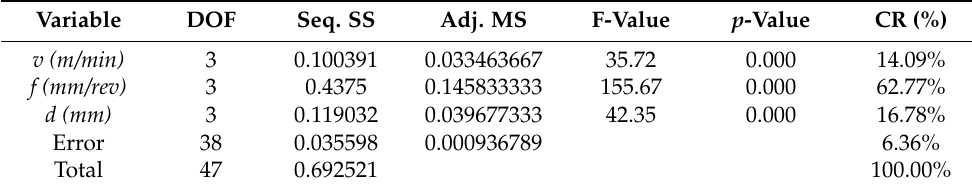
Table 13. Analysis of variance and percentage contribution results for SCE in HSM.